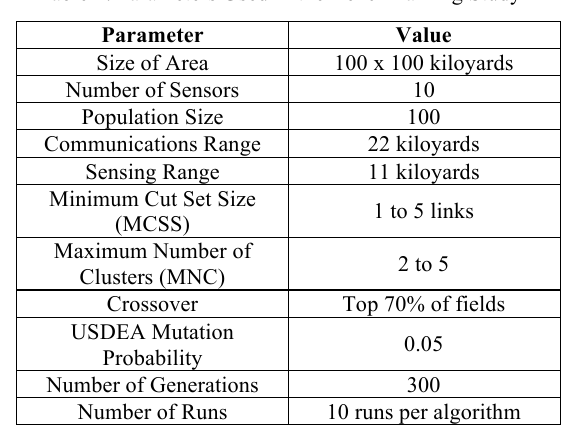
Table 1. Parameters Used in the Benchmarking Study